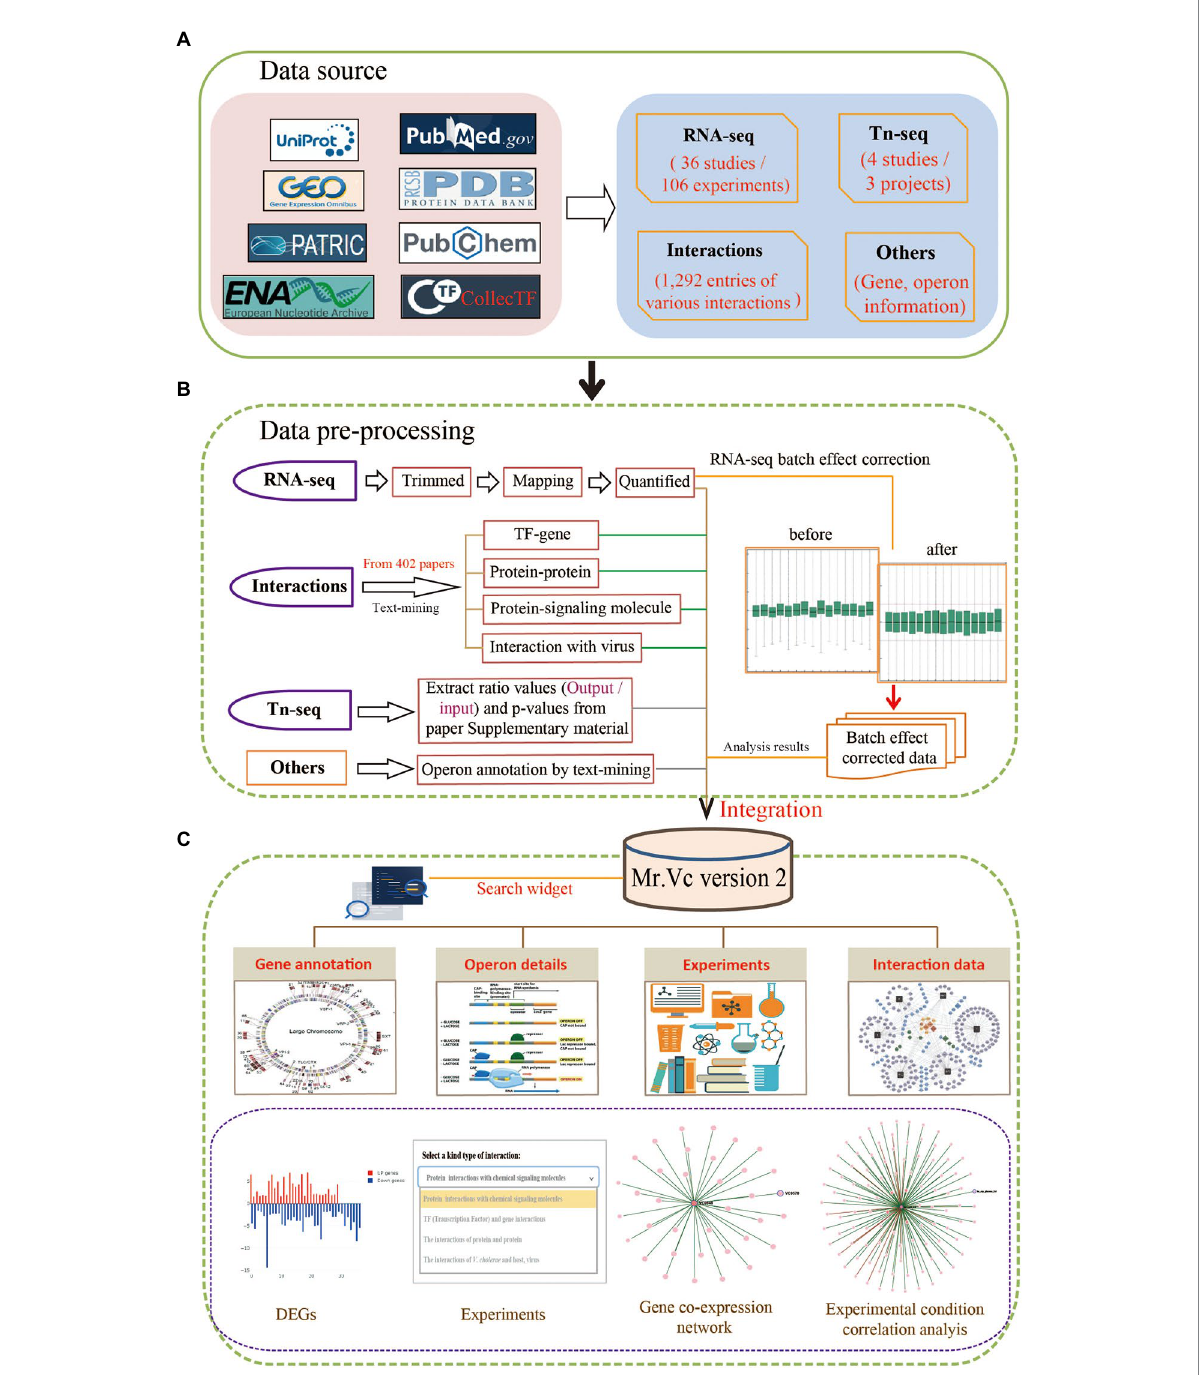
FIGURE 1 Overview of Mr.Vc v2. (A) The data source. All data including the raw sequencing data, information on genomic annotation, literature, Tn-seq data, and experimentally validated interactions were collected from public databases, such as NCBI GEO, ENA, PATRIC, Uniprot, collecTF, PDB, PubMed, and so on. (B) The data pre-processing. The RNA-seq raw data perform quality control, mapping, transcript quantification, and normalization to obtain high-quality data for further analysis. The resulting operon and interaction data were obtained from MEDLINE documents and literature in life science journals through text-mining analysis. The Tn-seq data were directly extracted from supplemental materials of literature. (C) The data integration. Mr.Vc v2 integrated polytype data, which was placed in the “Genes,” “Operons,” “Experiments,” and “Interactions” pages and provided a search